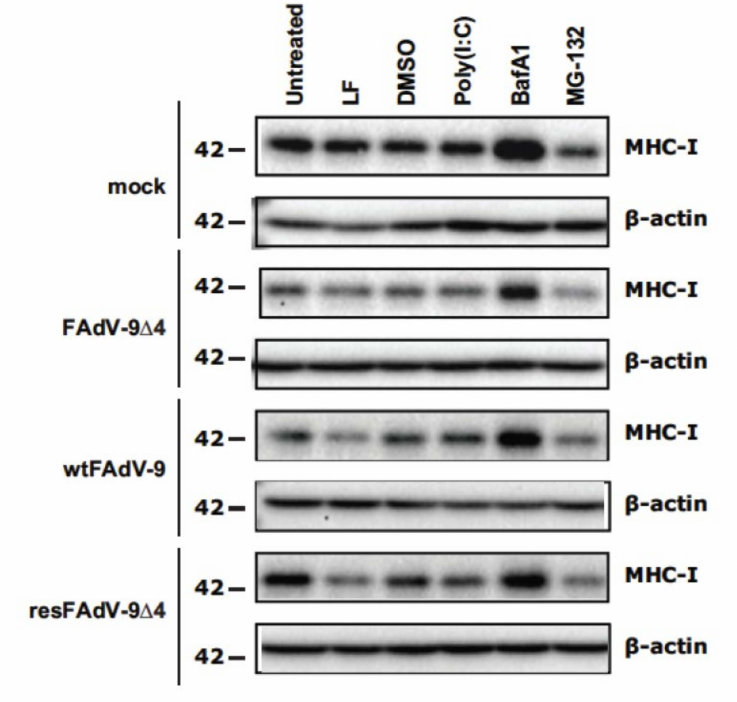
Figure 4. Western blot analysis of MHC-I heavy chain expression in virus-infected CH-SAH cells. Mock or FAdV-9, FAdV-9 ∆ 4, and resFAdV-9 ∆ 4-infected cells (MOI of 5) were either untreated, mock transfected with Lipofectamine 2000 (LF) (9 h prior to infection), treated with dimethyl sulfoxide (DMSO) solvent control (4 h.p.i.), transfected with polyriboinosinic: polyribocytidylic acid [poly(I:C)] (9 h prior to infection), treated with the lysosomal inhibitor bafilomycin A1 (BafA1) (4 h.p.i.), or treated with the proteosomal inhibitor MG-132 (9 h.p.i.). Whole cell lysates were harvested in RIPA buffer at 12 h.p.i. Cell lysates were analyzed by Western blotting for MHC-I expression. The levels of β -actin protein was determined and served as a loading